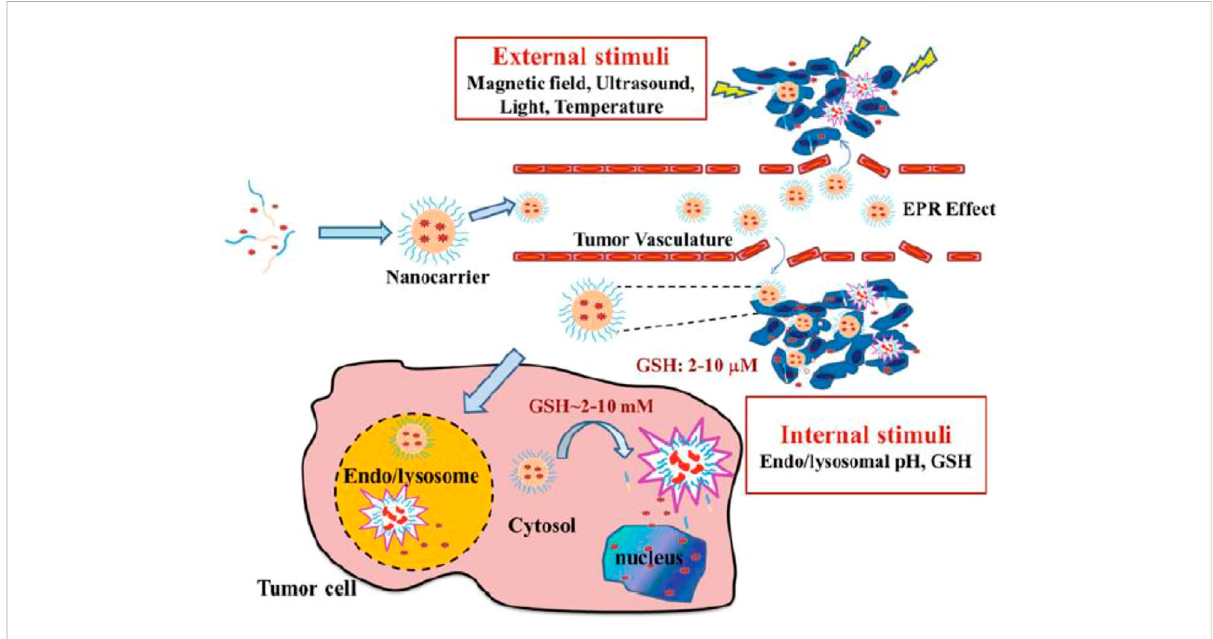
FIGURE 2 Illustrative description of controlled drug delivery of stimuli-responsive PMs. It is reprinted with permission from Springer (Singh A. et al.,